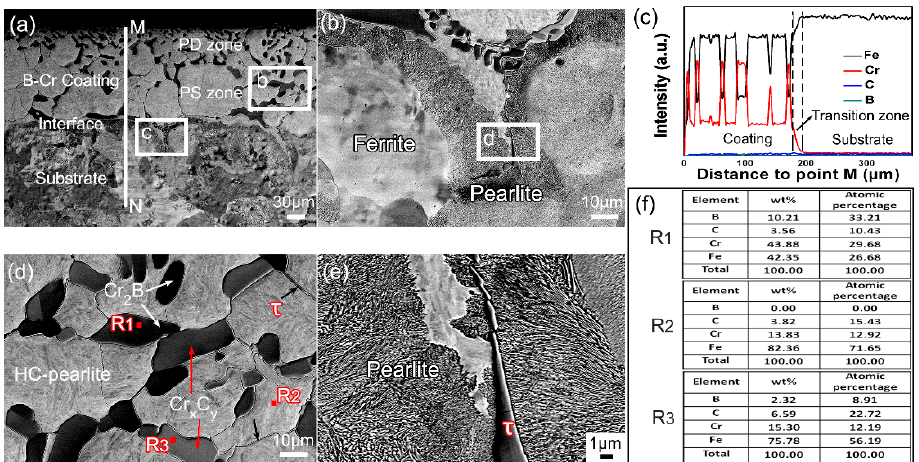
Figure 5. Microstructure and elements distribution after the BC-2 treatment: ( a ) BSEI image of the cross-section; ( b , d , e ) high-magnification BSEI image corresponding to the white boxes; ( c ) EDS line scanning; ( f ) EDS point analysis of R 1 , R 2 , and R 3 in ( d ).